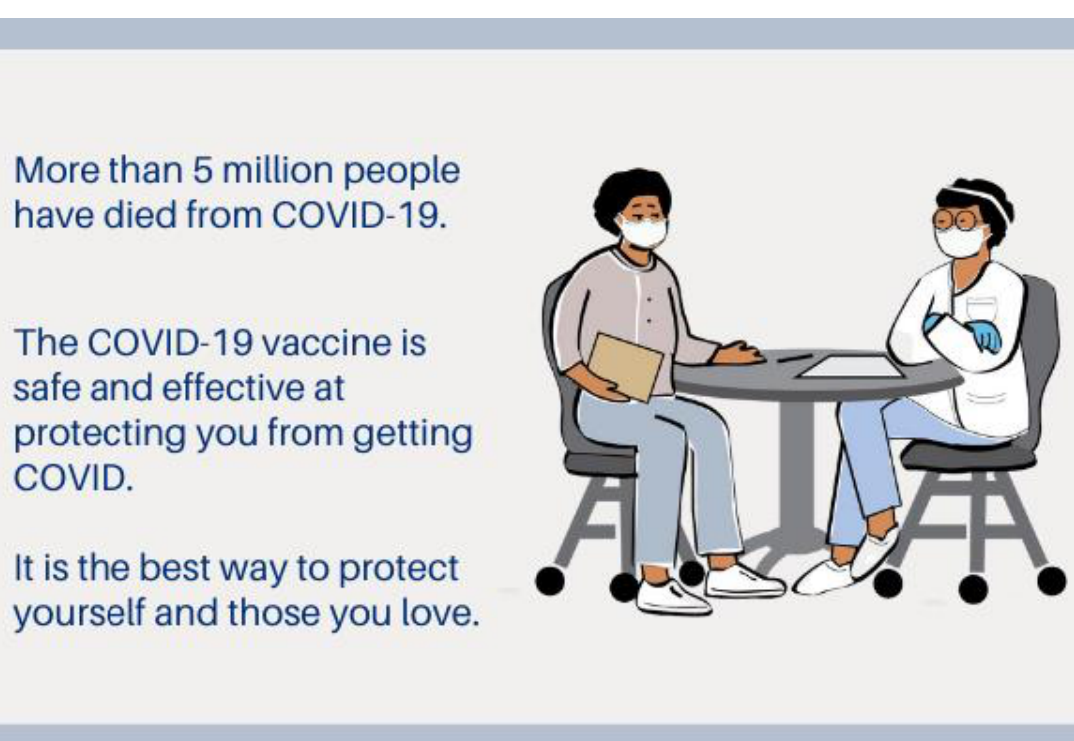
Figure A1. Disease outcome—healthcare